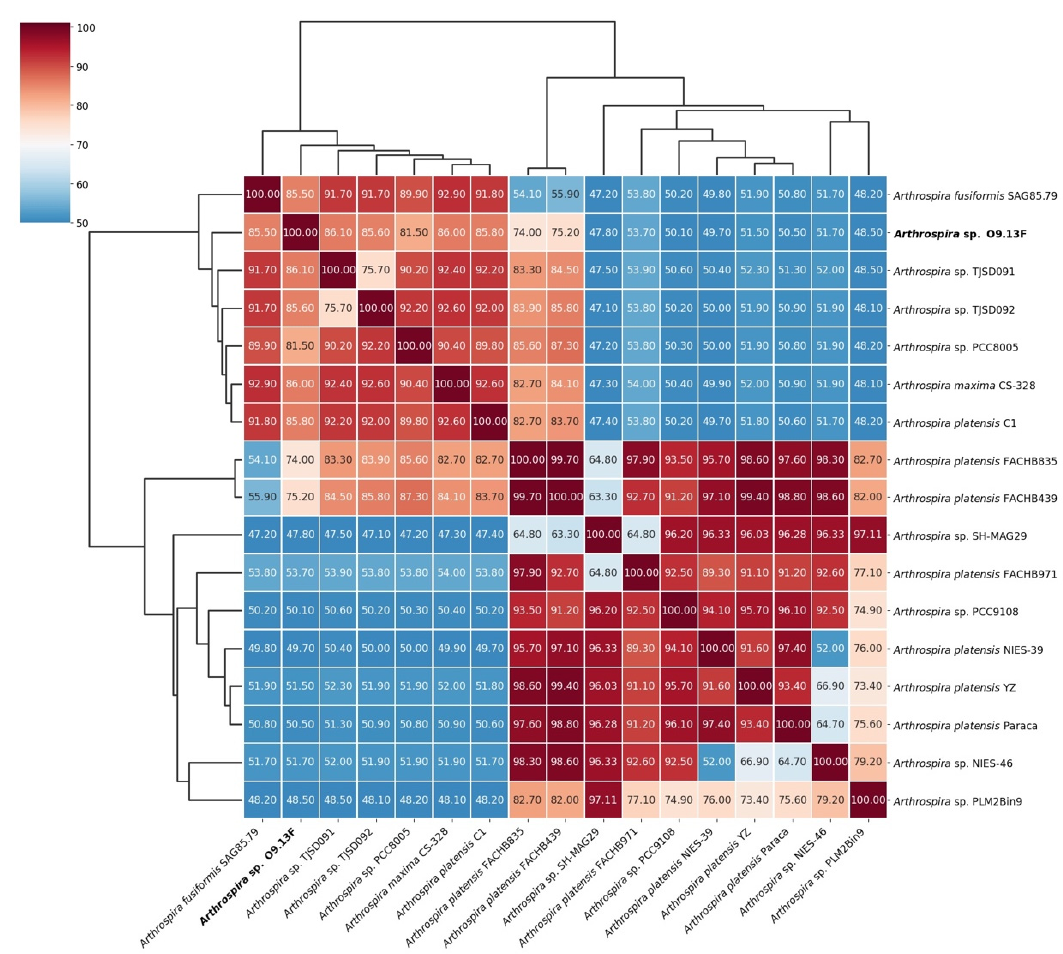
Figure 8. In silico DNA–DNA hybridization of 17 Arthrospira genomes available in the GenBank calculated with GGDC 2.1 [86] with BLAST+ as a local alignment tool.